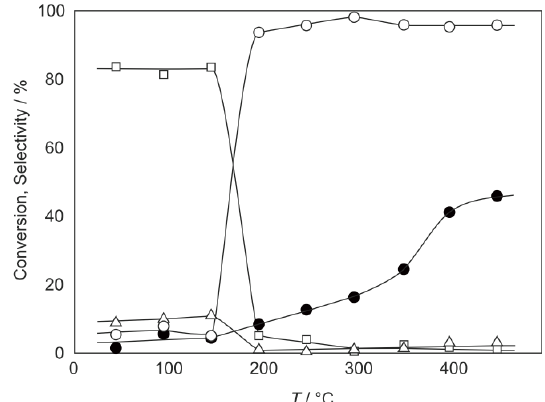
Figure 29. Effect of temperature on the S -acetylation of benzenethiol with acetic acid over (H O) [(Mo Cl )Cl ]·6H O/SiO . Following the activation of the supported cluster 3 2 6 8 6 2 2 (30 mg, 1.23 μmol) in a hydrogen stream (300 mL/h) for 1 h, reaction was initiated by introduction of a mixture of benzenethiol (102 μL/h, 1.0 mmol/h) and acetic